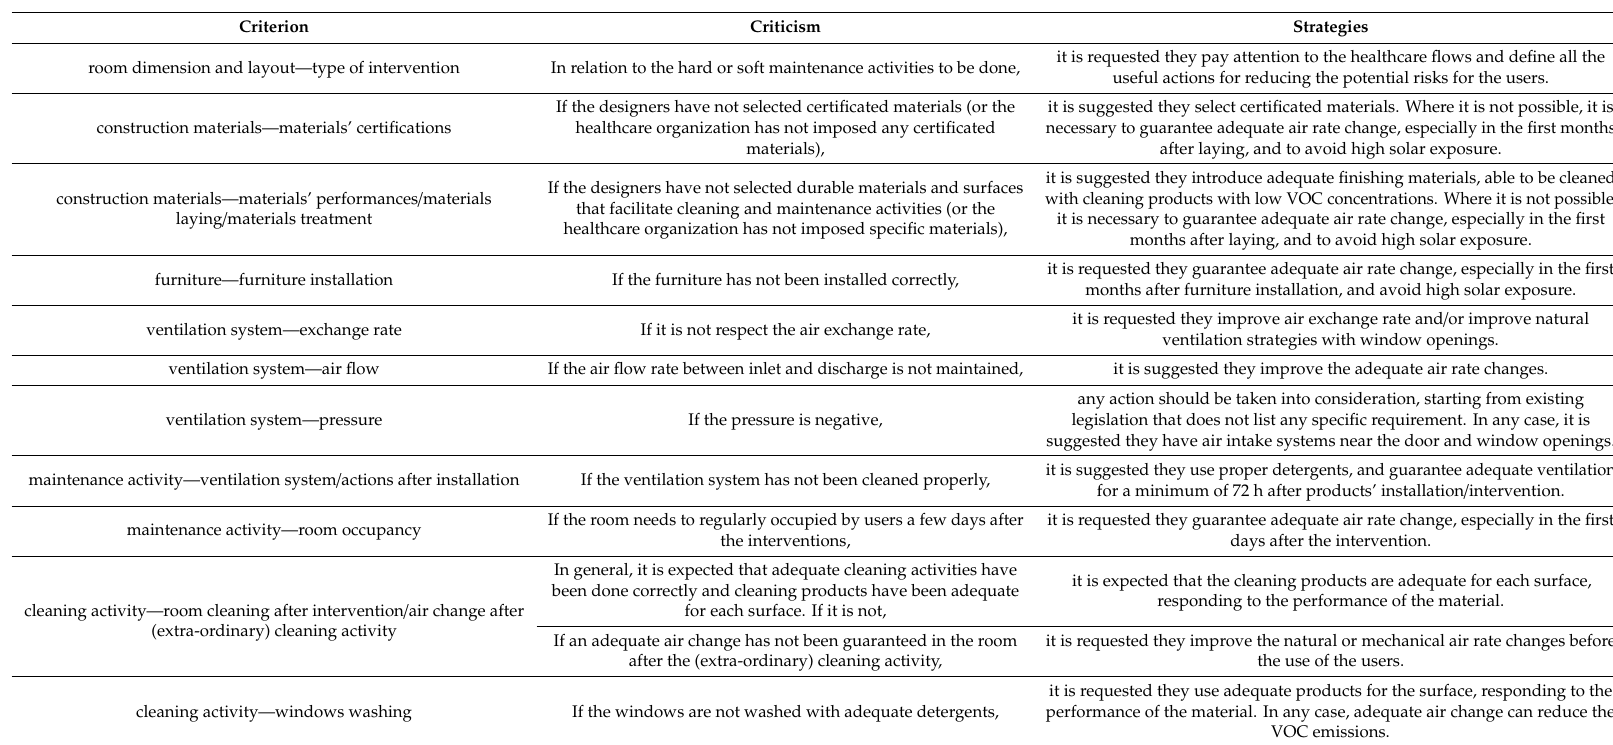
Table 6. Strategies for healthy outcomes for maintenance activities and